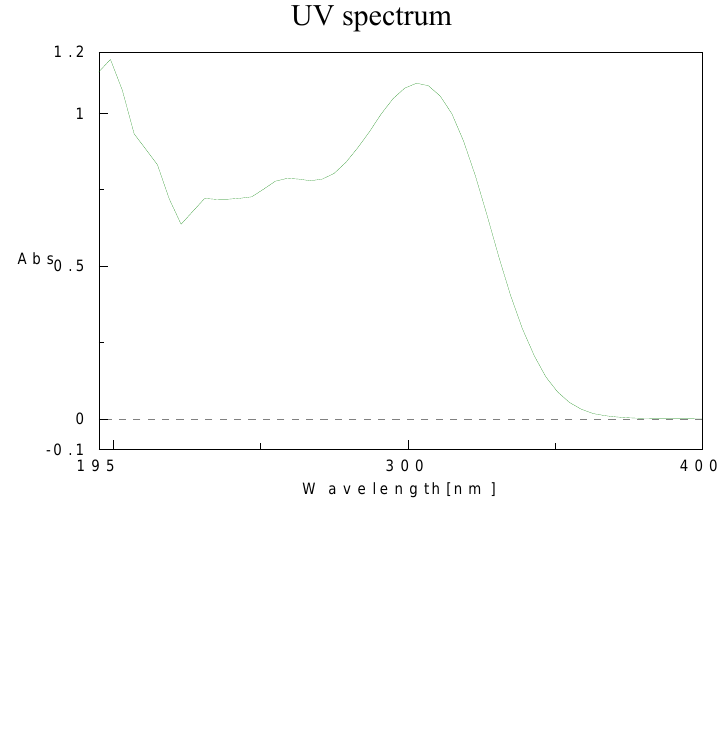
( E )-Methyl 3-(4-(phenylthio)phenyl)but-2-enoate [( E )-1d] Yellow oil. R ( n -hexane/ethylacetate 94:6); 1 H-NMR (CDCl )   ppm): 2.58 (d, 3H, J = 1.2 Hz), 3.77 (s, 3H), 3 6.15 (q, 1H, J = 1.2 Hz), 7.25-7.46 (m, 9H); HPLC-UV/PAD analysis: RT 9.2 min. UV spectrum 1 .2